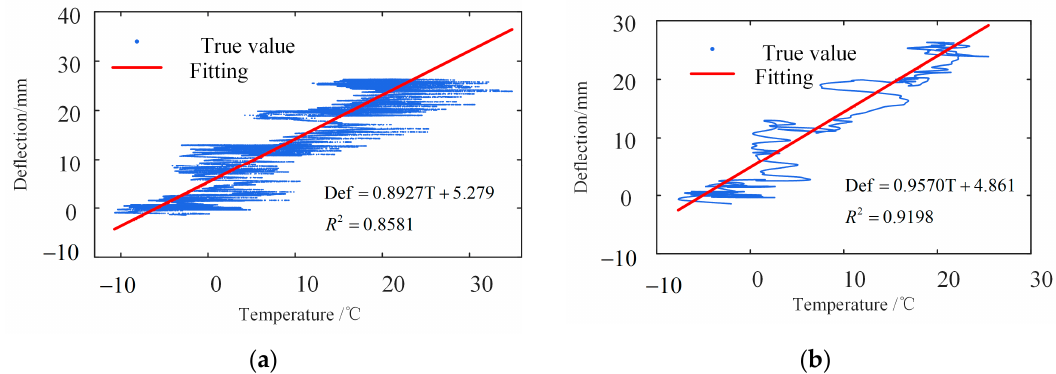
Figure 18. Comparison between the calculation results of the FEM and the separated deflection.